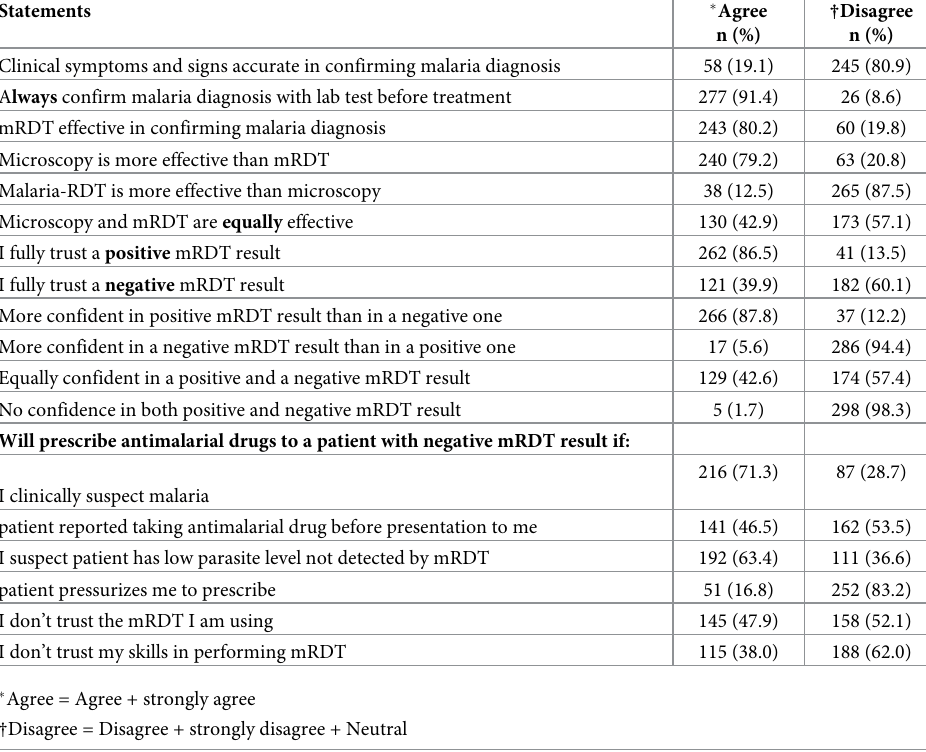
Table 2. Health workers’ perception of malaria rapid diagnostic test, Ebonyi state,